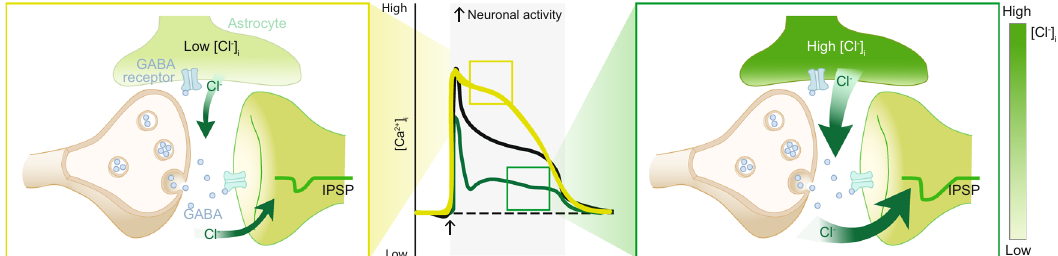
Fig. 6 | Astrocytic [Cl − ] i facilitates neuronal inhibition by supplying Cl − for GABAergic synapses: the hypothesis. Synaptic GABA release opens GABA A R in astrocytes leading to Cl − ef fl ux. Astrocytic [Cl − ] i affects the duration of neural activation. Under conditions of low astrocytic [Cl − ] i , neuronal activity is sustained for a longer period of time due to a reduction in the strength of GABAergic transmission over time. When astrocytic [Cl − ] i is high, activation of astrocytic